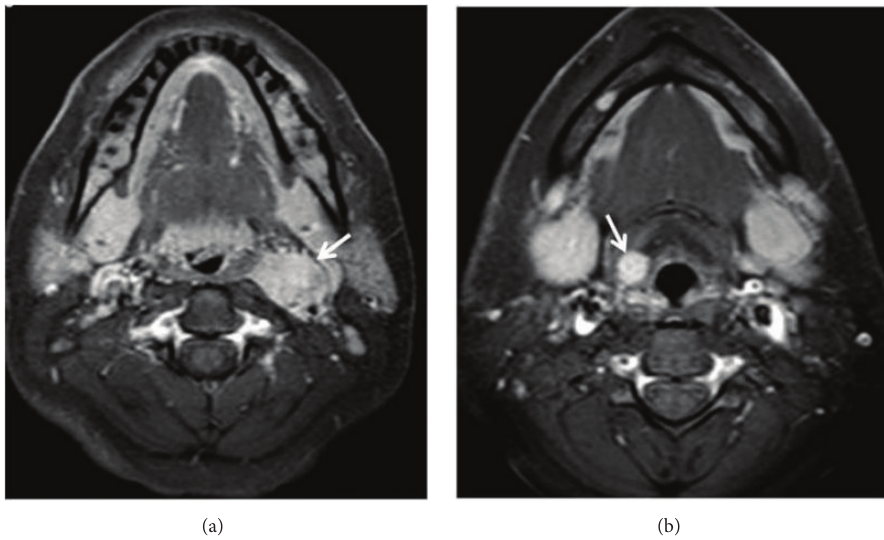
Figure 3: Enhanced lesions (arrows) are seen at left carotid bifurcation (a) and right supraglottic larynx (b) in axial contrast enhanced T1 weighted turbo spin echo spectral fat saturation inversion recovery image (T1 TSE SPIR).